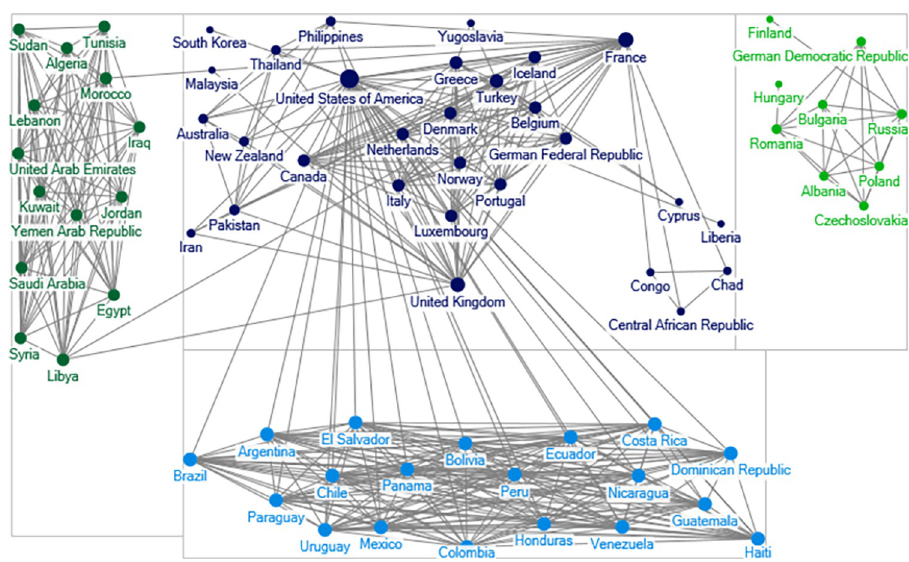
Fig 1. Political alliance network in 1965. A node is a state name. Ties connecting nodes represent political alliance relationship. The lines are undirected. Greater size of the notes indicates that the states have more political alliance ties.